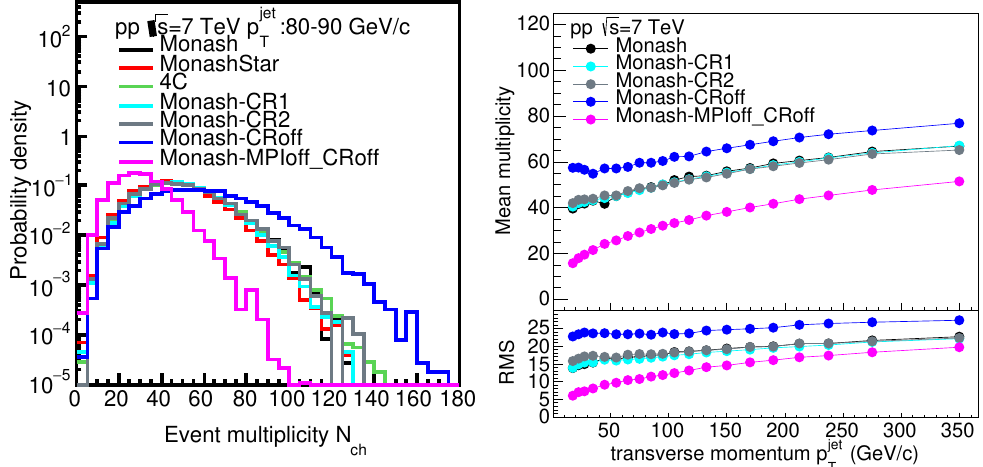
Figure 1. ( Left ) Multiplicity distributions for different tunes and settings in events where the p jet reconstructed jets falls in a given p T bin; ( Right ) The mean values of the distributions are shown as a function of the p jet . The RMS is the relative mean squared value of the distribution. T